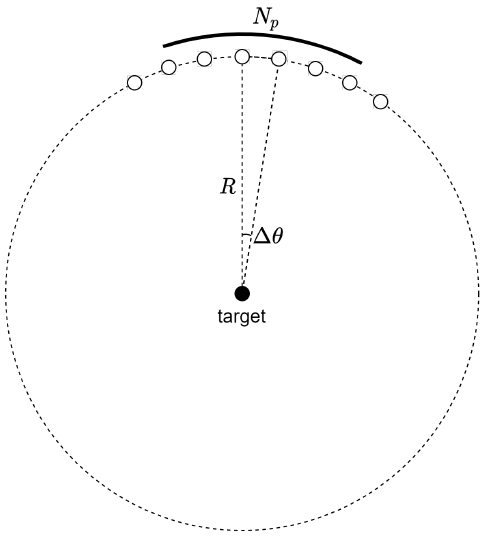
Figure 1. Geometry for circular video